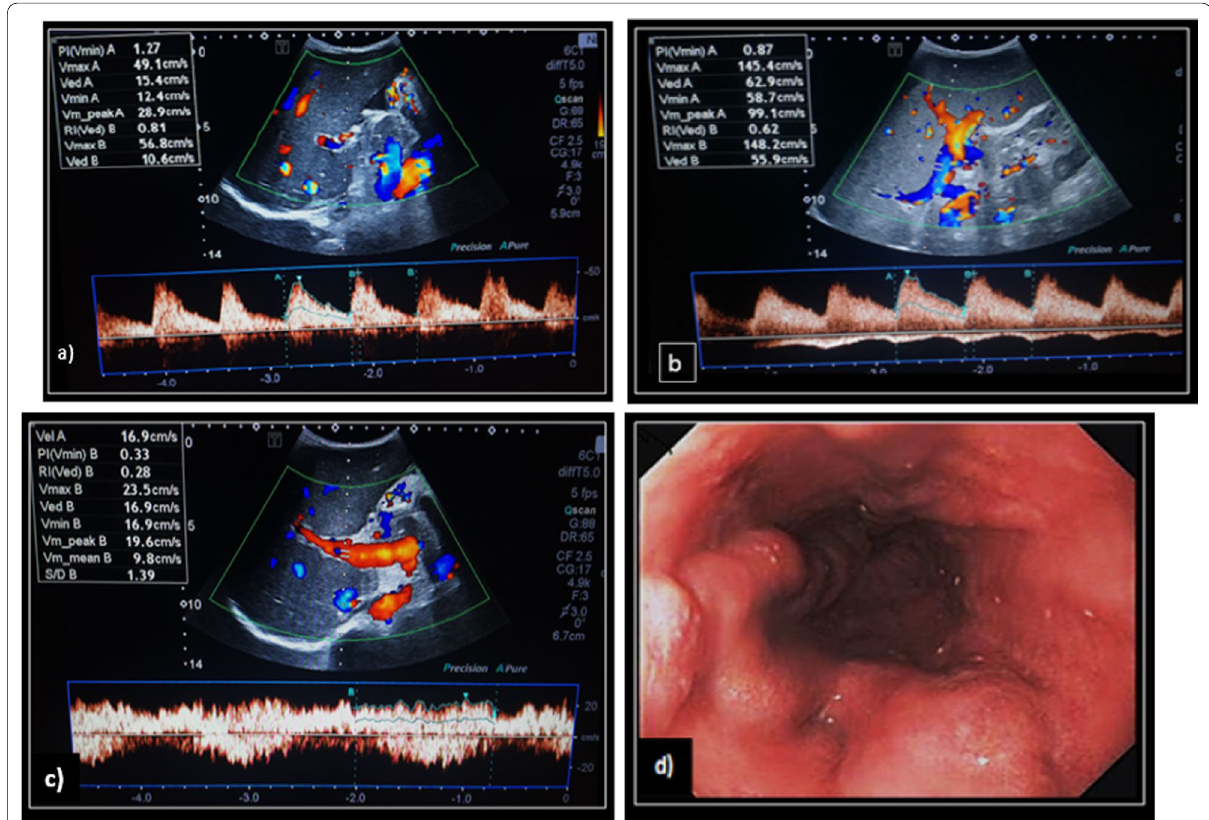
Fig. 2 52 y male patient with chronic liver disease, a presents Doppler U/S of hepatic artery with HAPI: 1.27 and HARI: 0.81. b Presents Doppler U/S of splenic artery with SARI: 0.62, the splenic bipolar diameter is 18 cm. c Presents Doppler U/S of PV with MVPV: 19.6 cm/s. PV diameter is 14 mm. ascites was also noticed. d UGIE revealed grade III oesophageal